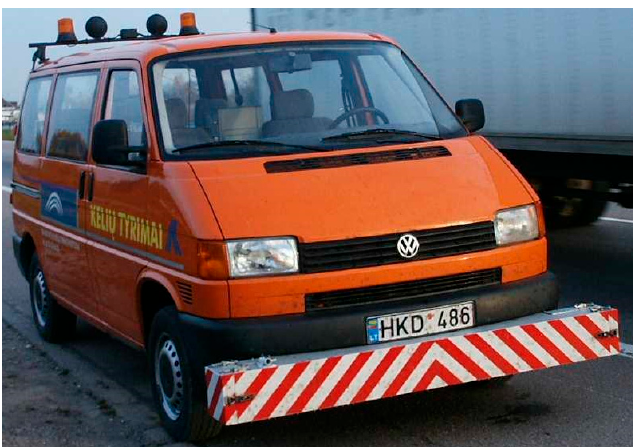
Figure 23. Laser profilograph DYNATEST 5051 RSP mounted on the VW Transporter. Reprinted from ref. [58].